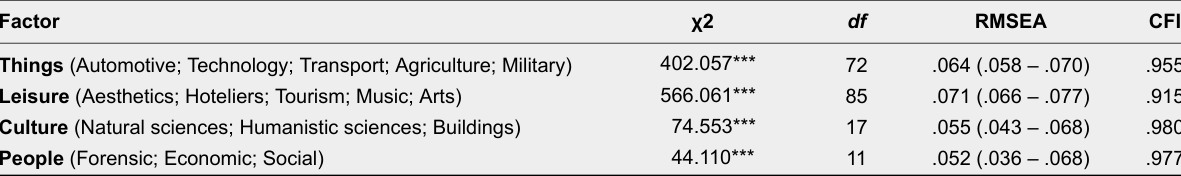
Four-Factor Fit Indexes for CFA Models Tested with Maximum Likelihood (N = 1117)